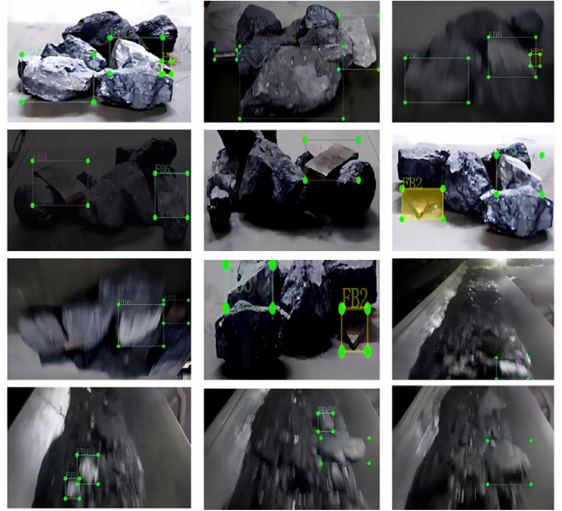
Figure 7. Partial images of the